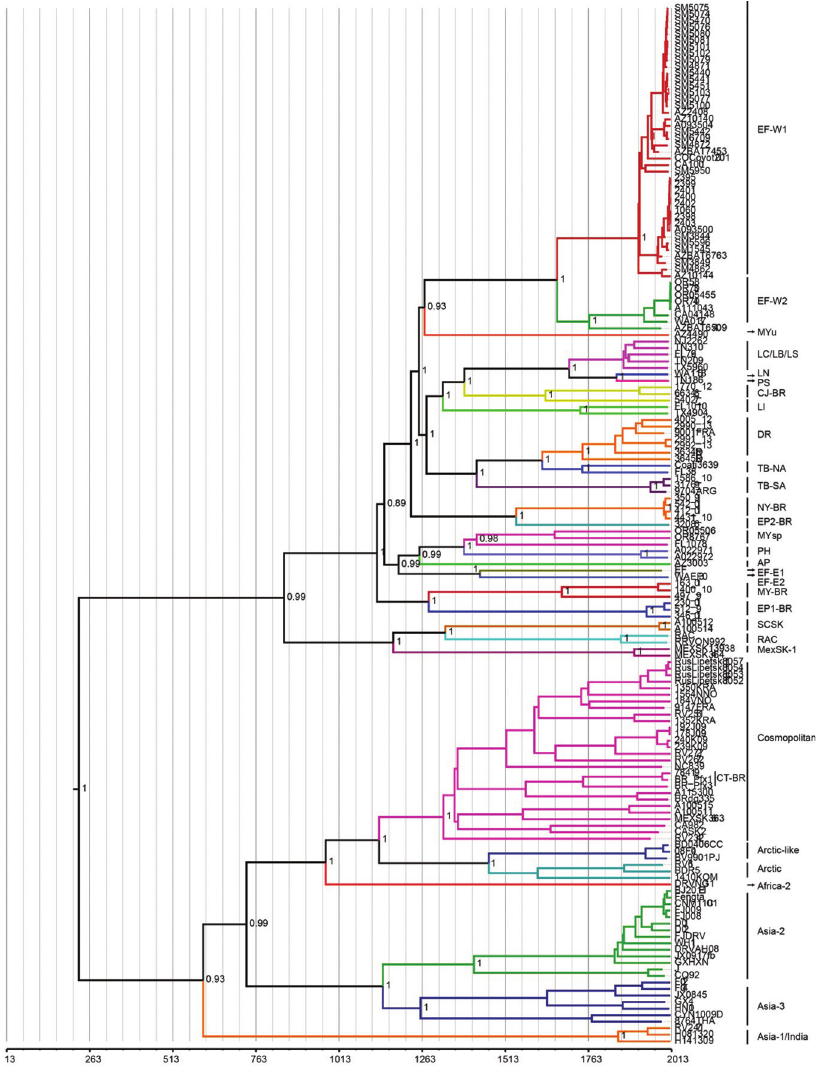
Figure 1 - Maximum clade credibility tree inferred from the concatenated G and L genes. The branches are calibrated according to the year when the lin- eage was isolated. The scale at the bottom of the graph is in years and can be used to identify when the separation events between RABV lineages oc- curred. The groups are color-coded according to the classification proposed by Bourhy et al. (2008), and Kuzmin et al.